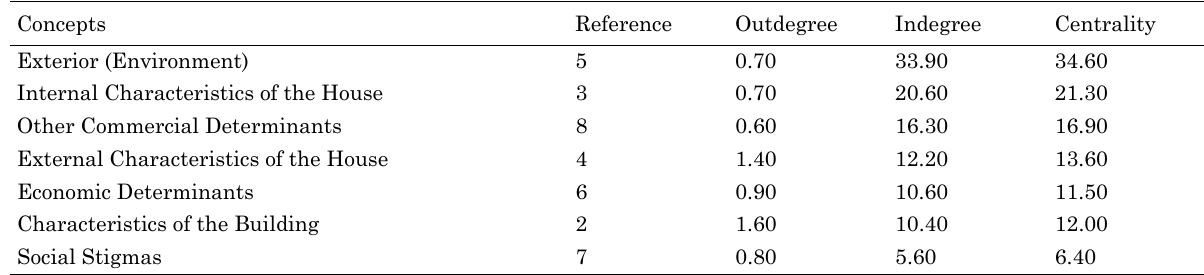
Table 2. Major determinants of housing sales and TOM [based on